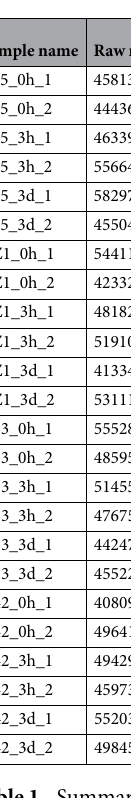
Table 1. Summary of transcriptome sequencing